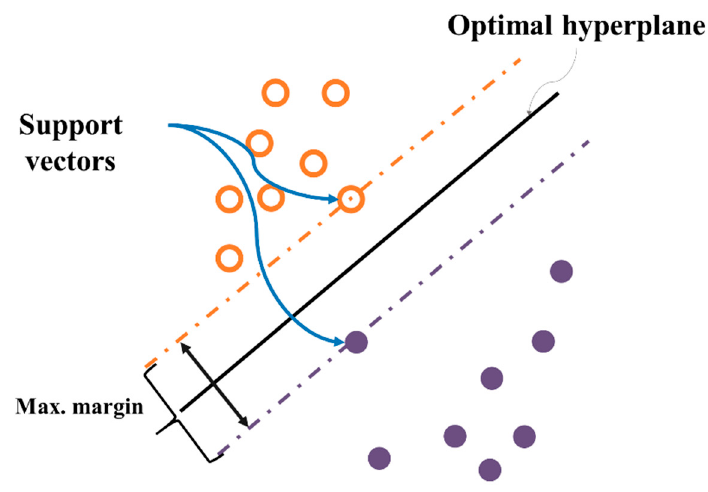
Figure 4. Structure of support vector machine (SVM).